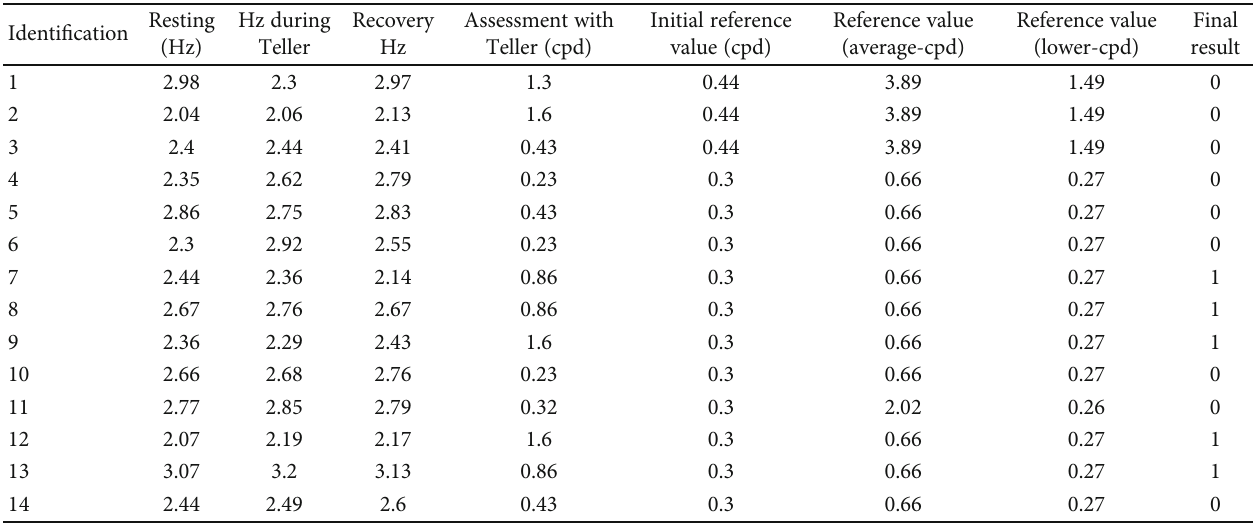
Table 3: Continuation of individual sample values.